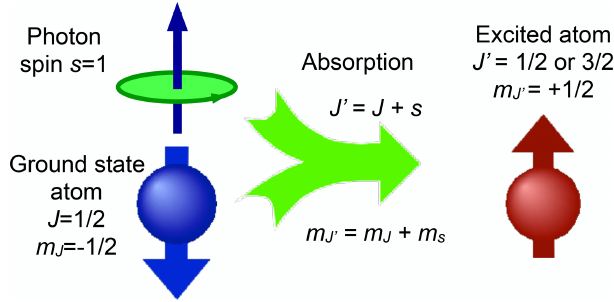
Figure 3. A simple absorption process illustrating angular momen- tum conservation in atomic physics.